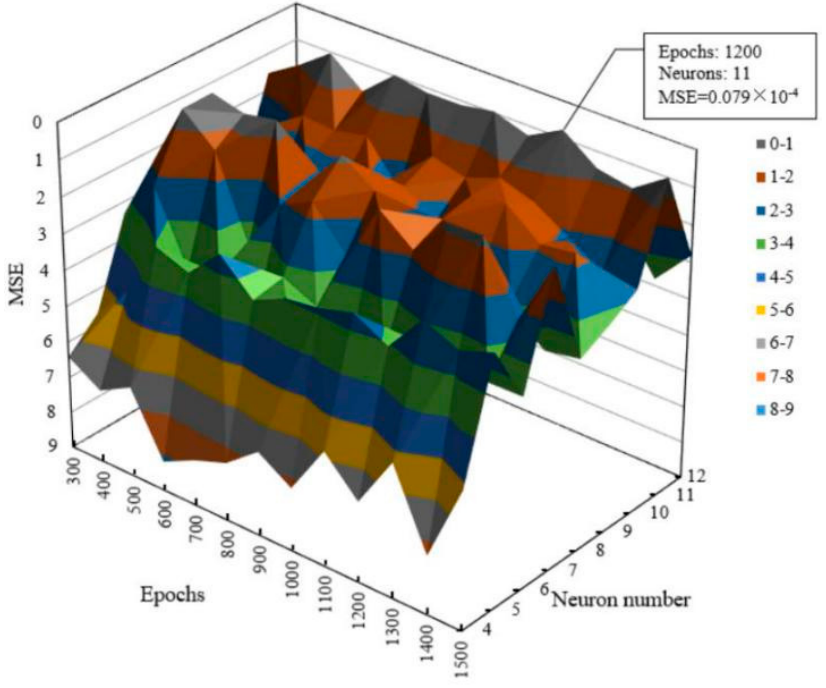
Figure 10. Variation in MSE with different numbers of training epochs and neurons.